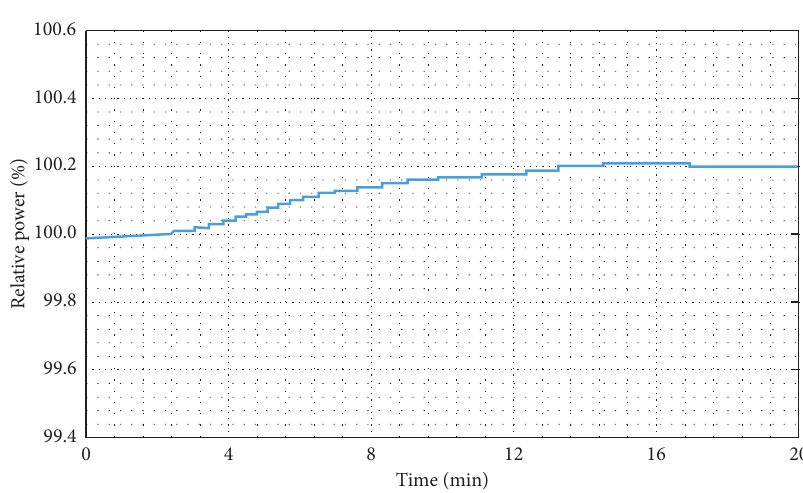
Figure 19: Relative power of #1 module in case